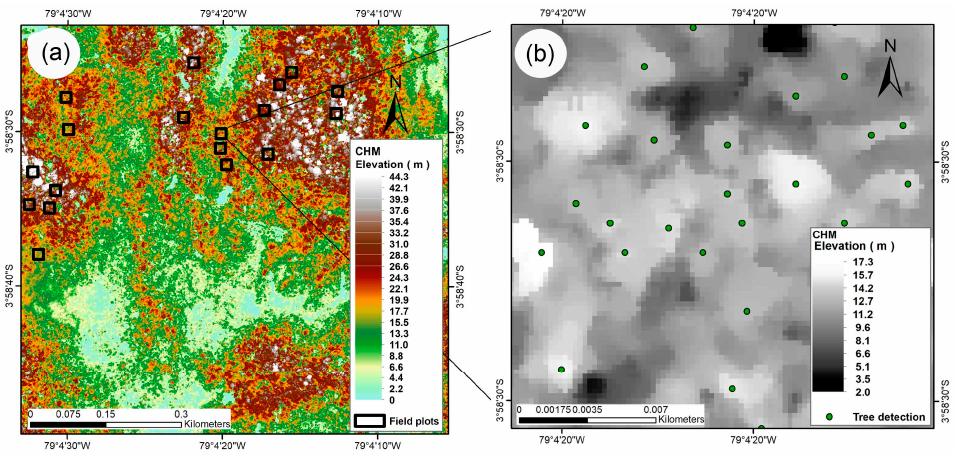
Figure 5. ( a ) Canopy Height Model (CHM), including field plots; ( b ) Example of the individual tree classification for one plot in the study